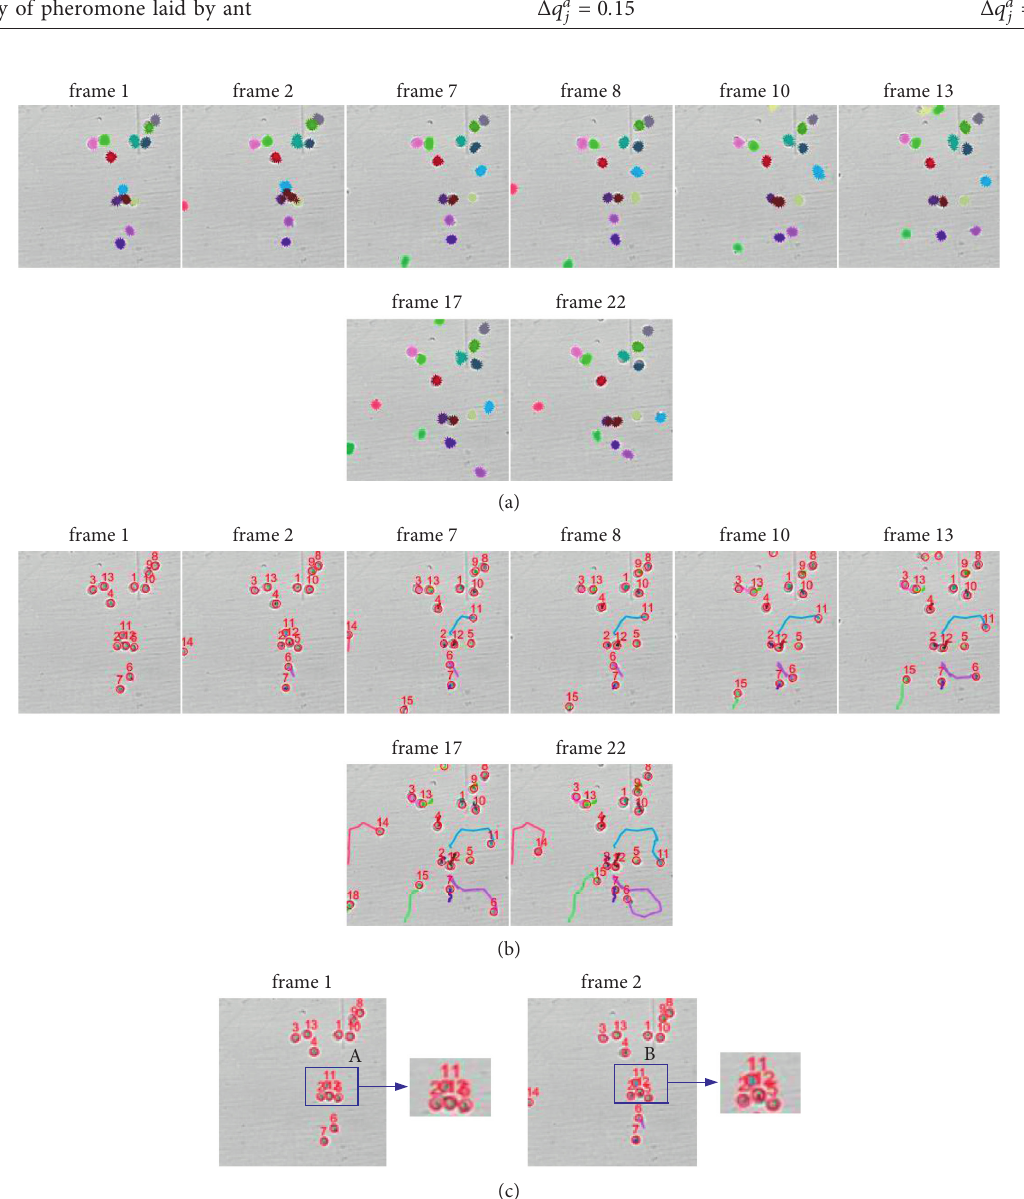
Figure 5: Tracking results with our proposed algorithm in different frames. (a) Results of ant distribution in different frames. (b) Tracking partial results of original RGB image sequences. (c) Tracking results of clustering cells in original RGB image